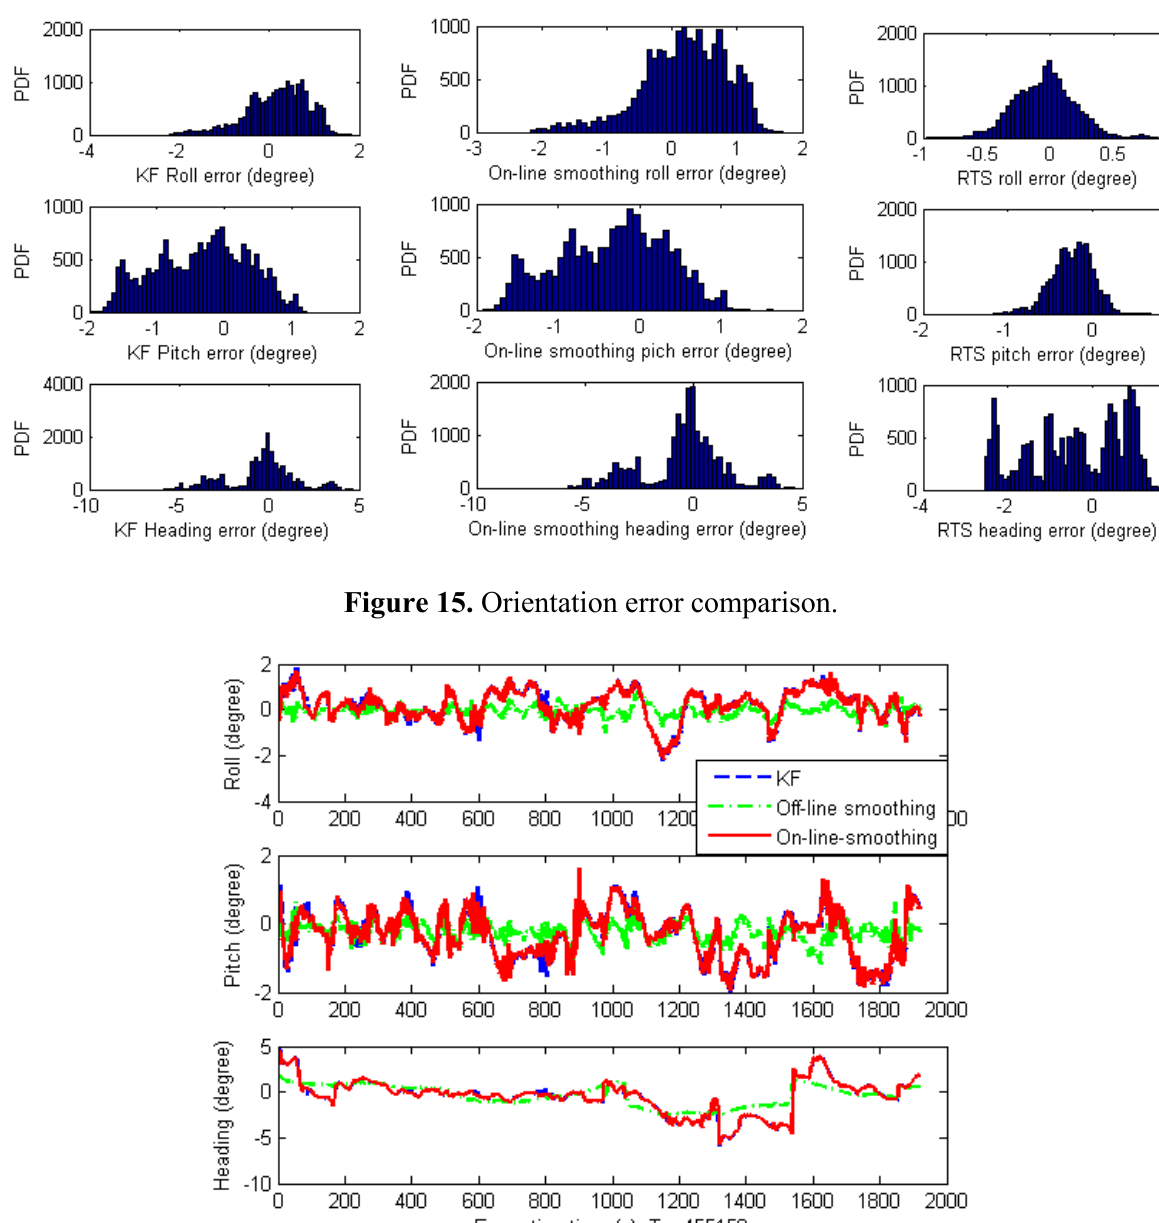
Figure 14. Orientation error distributions of KF, on-line smoothing, and RTS smoother.